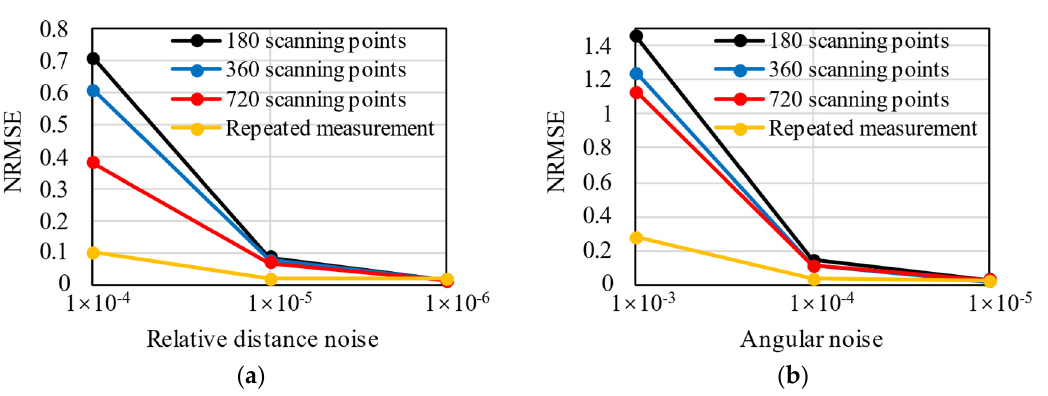
Figure 9. The 𝑁𝑅𝑀𝑆𝐸 of hybrid analysis for various relative distance noise ( a ) and various angular noise ( b ).